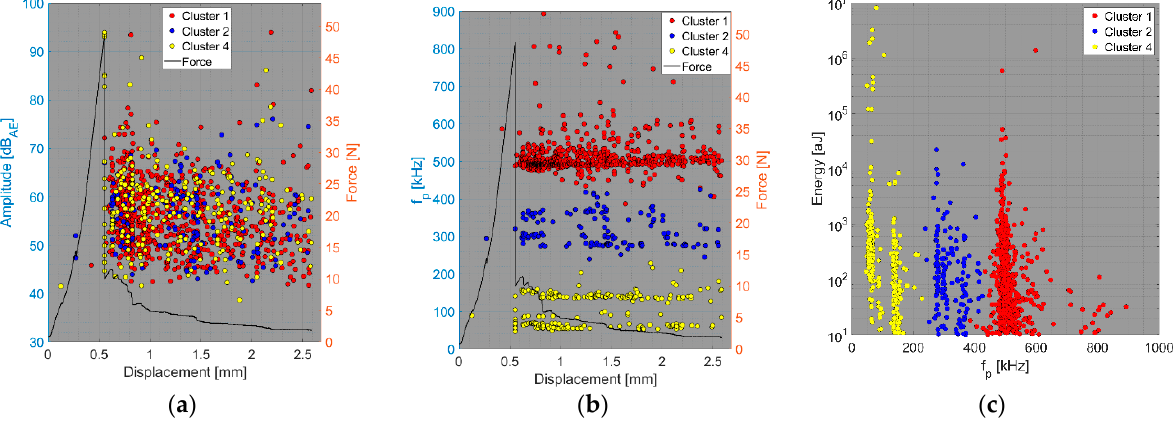
Figure 16. Clustering results for a UCT representative sample using the spectral clustering algorithm (DWC dataset).